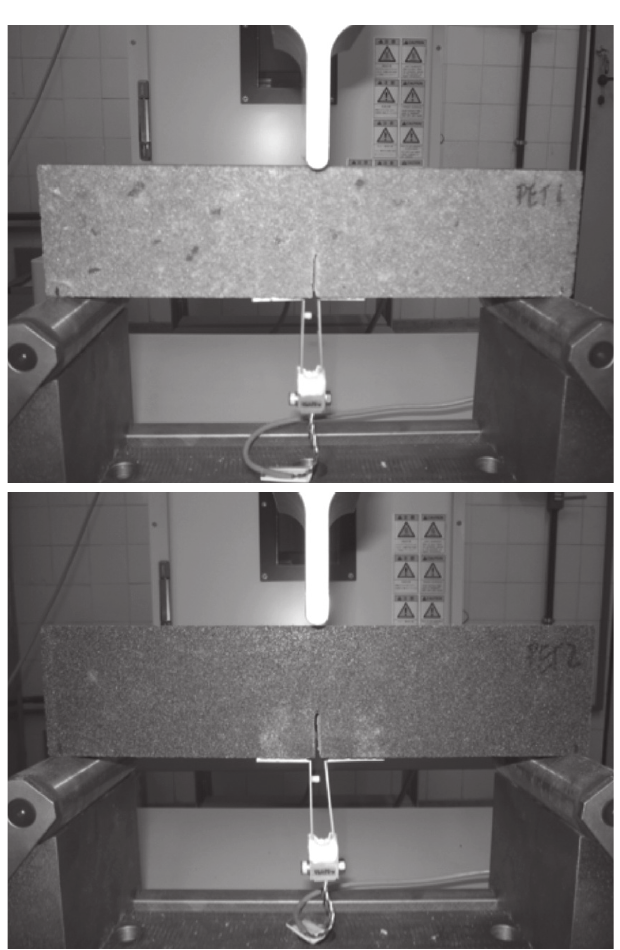
Figure 1. Three-point bending test set-up for polymer mortar with fresh and recycled